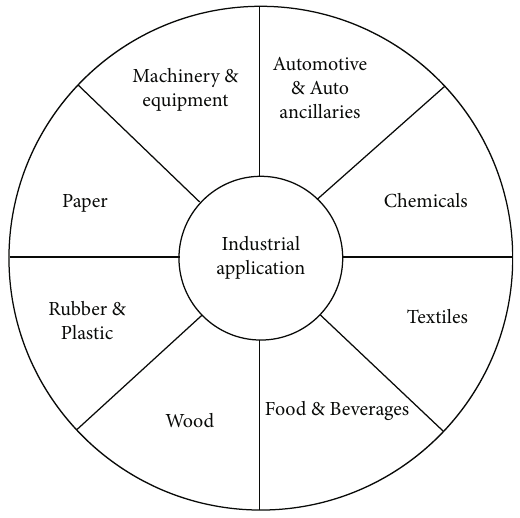
Figure 1: Solar usage in